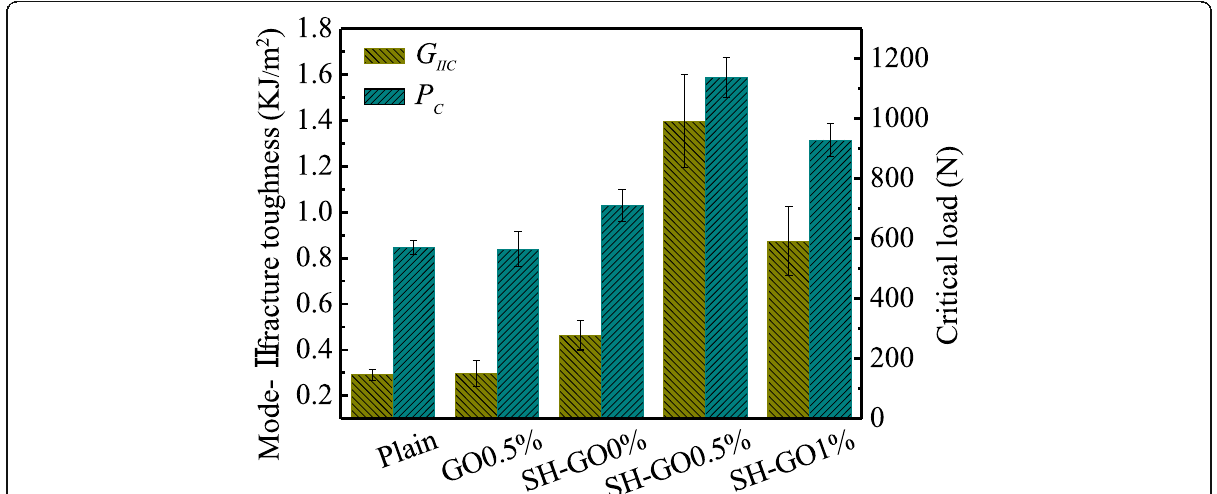
Fig. 13 Comparison of mode-II fracture toughness G IIC and critical load P C for various specimens during ENF